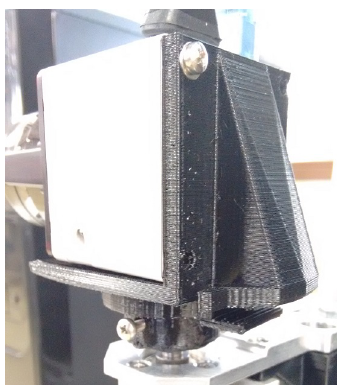
Figure 4. 3D printed support for fixing the Hokuyo LIDAR toppled on top of the motor